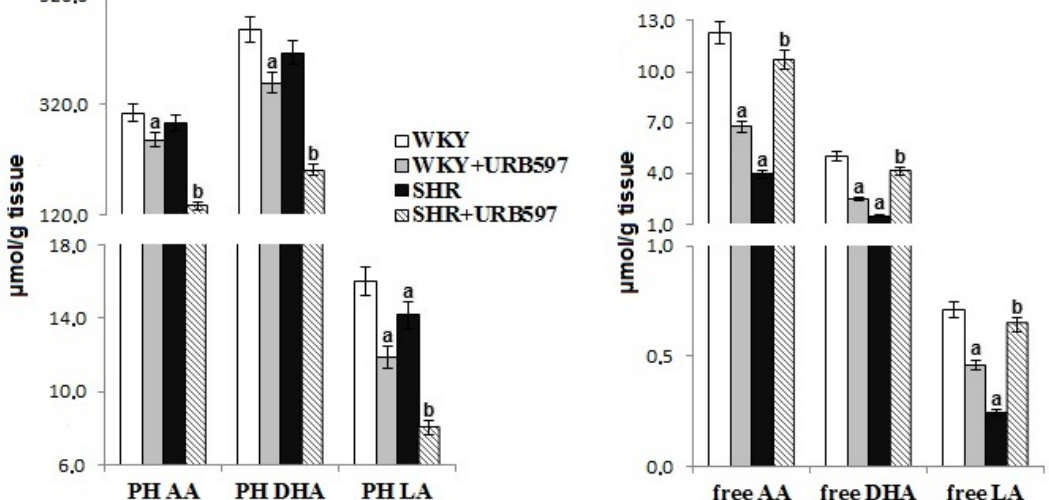
Figure 3. The levels of phospholipid and free fatty acids in the brain of spontaneously hypertensive rats and hypertensive rats after URB597 administration. Data points represent the mean ± SD, n = 6; (a, significantly different from the WKY group, p < 0.05; b, significantly different from the SHR group, p < 0.05).